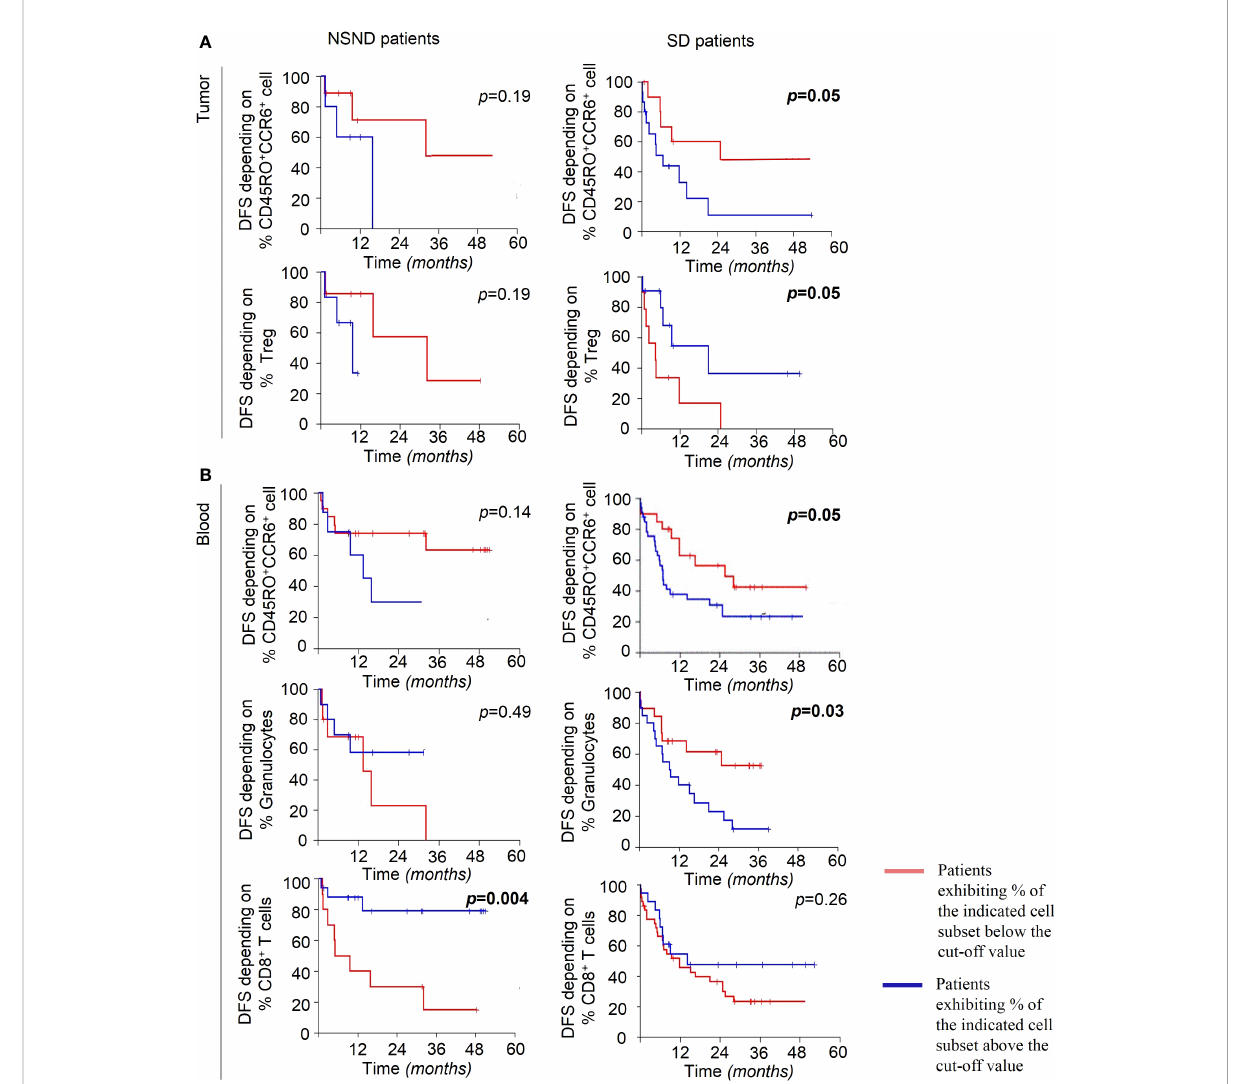
FIGURE 6 Disease-Free Survival (DFS) of OSCC patients. (A) DFS of NSND patients (left panels) and SD patients (right panels), dichotomized to the medians of percentages of CD45RO + CCR6 + CD4 + T cells (19.2%) (upper panels) and Treg (18.6%) (lower panels) in TME. (B) DFS of NSND patients (left panels) and SD patients (right panels), dichotomized to the medians of CD45RO + CCR6 + CD4 + cells (30%) (upper panels), of granulocytes (66%) (middle panels) and of CD8 + T cells (4.7%) (lower panels) in blood. The cut-off for each cell subset is the median value obtained for the whole cohort of patients (87 OSCC). Kaplan-Meier Disease-Free Survival curves are presented. The blue and red lines represent patients exhibiting percentages of the indicated cell population above and below the cut-off value, respectively. The Log-Rank test was used to calculate the differences observed between the groups of patients. p ≤ 0.05 was considered as signi fi cant.